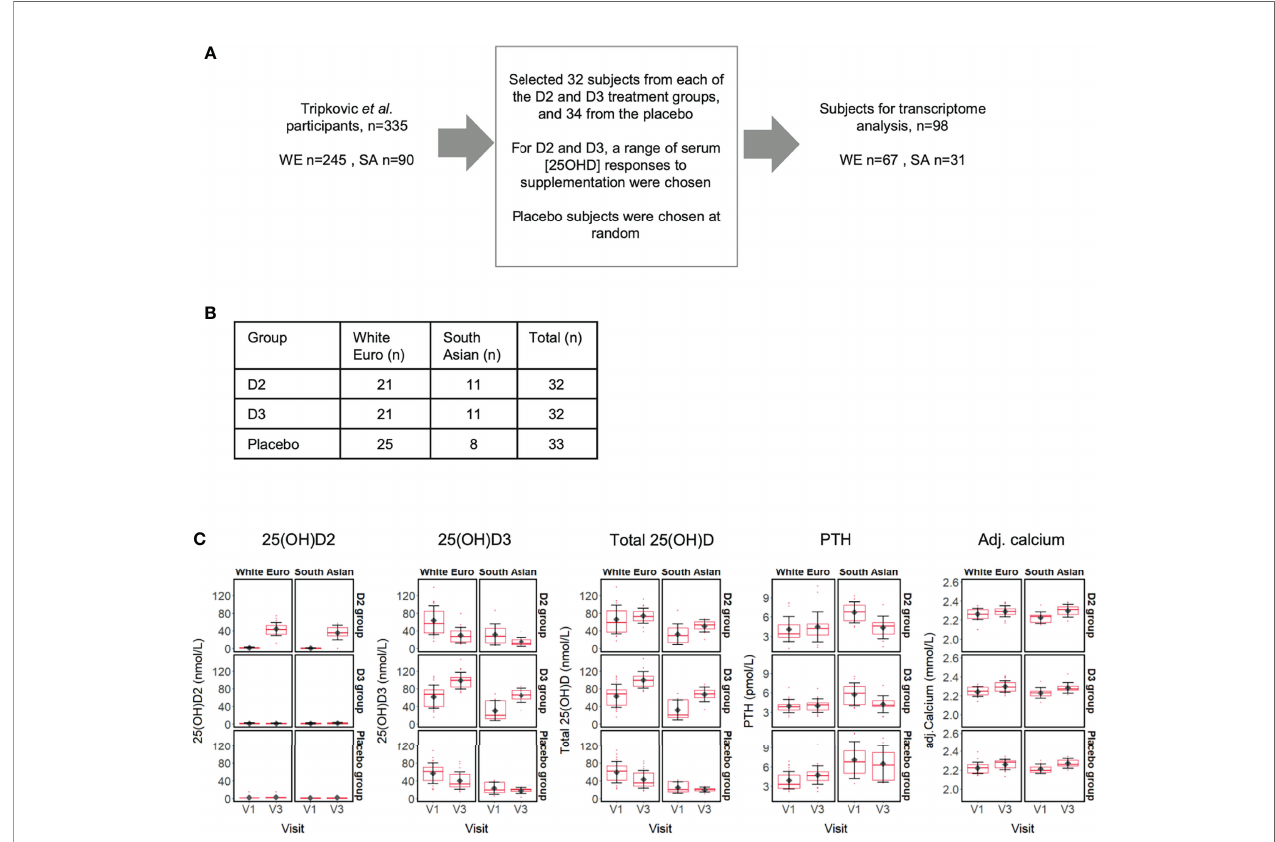
FIGURE 1 | (A) Selection of 98 subject participants from the Tripkovic et al. (2017) study (28) for transcriptomic analysis of their V1 (baseline) and V3 (12-week) samples in the present study; (B) Ethnicity and treatment group membership for the 97 subjects for which transcriptomic data was obtained (data for one South Asian subject from the placebo group did not pass quality control); (C) Metadata on serum concentrations of 25(OH)D 2 , 25(OH)D 3 , total 25(OH)D, PTH and calcium (albumin-adjusted) for the 97 subjects (see Supplementary Data File 1 for details). Participants were selected to provide comparable numbers between the placebo and the two vitamin D treatment groups, covering the full range of serum responses to supplementation within the D 2 and D 3 treatment groups, as judged from the measured changes in serum 25(OH)D 2 or 25(OH)D 3 concentrations between V1 and